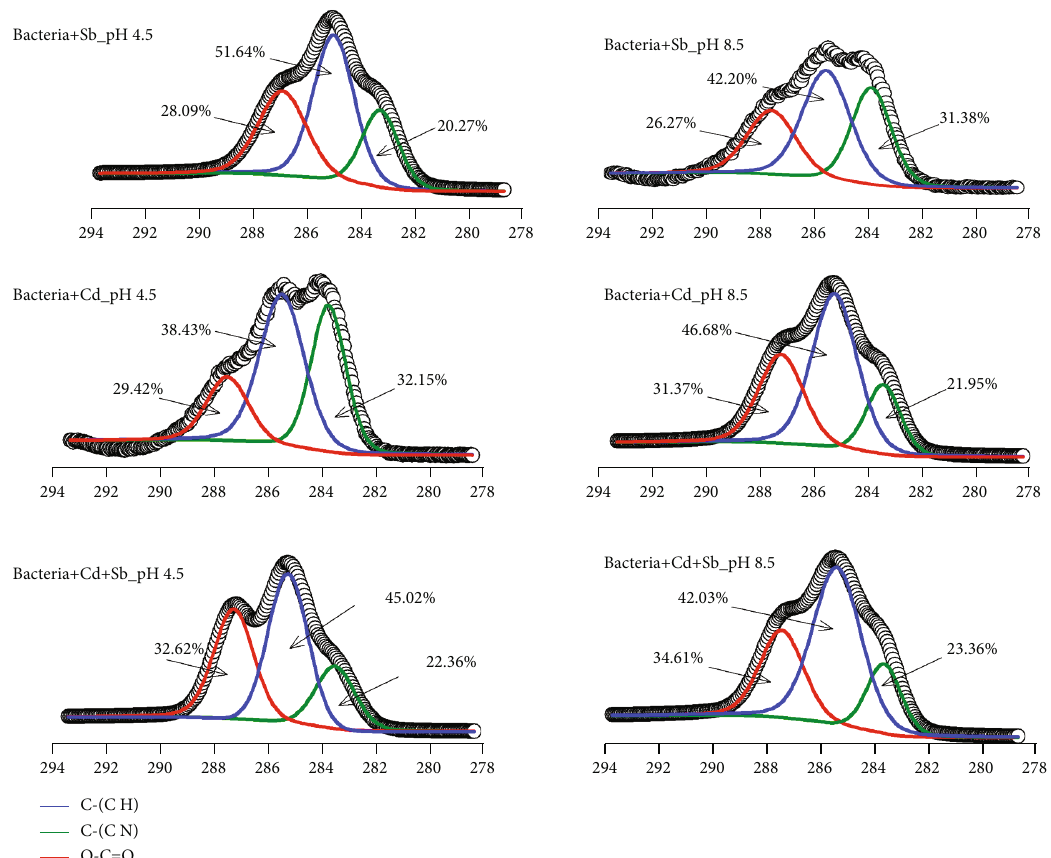
Figure 7: High-resolution C 1s XPS spectra of the Bacillus cereus cell after the sorption of Cd(II) and/or